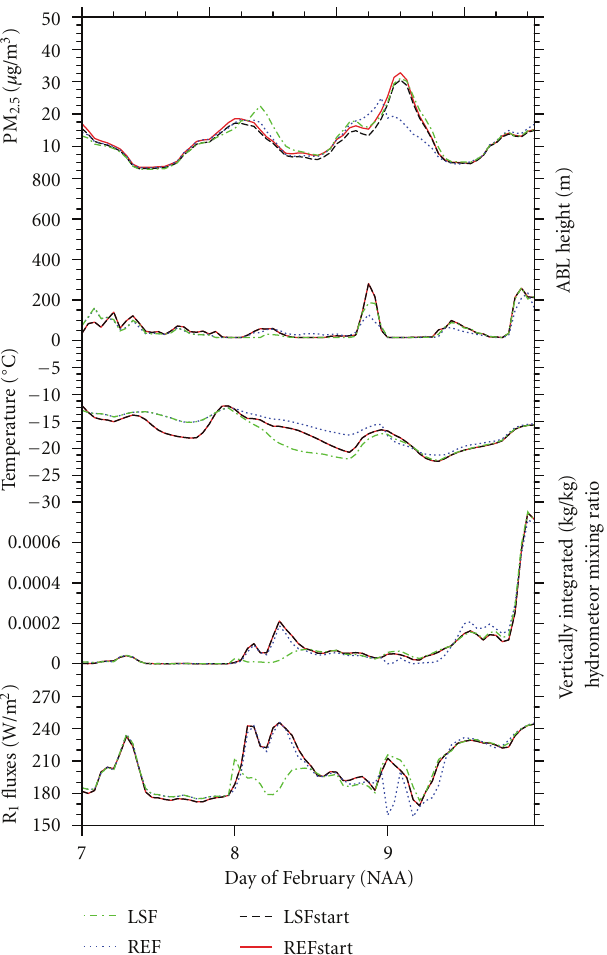
Figure 9: Meteorological variables and PM 2 . 5 concentrations simulated by REF, LSF, and REFstart and LSFstart averaged over the nonattainment area during February 7–9, 2009